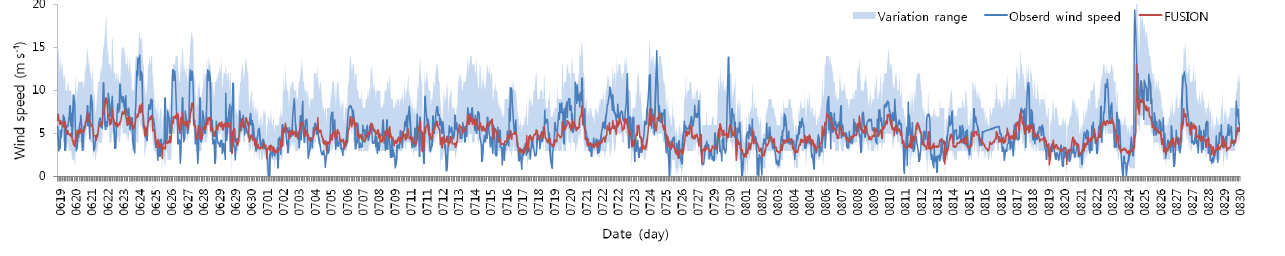
Figure 3. The contrast of 0–24h single-valued forecast, variation range of wind speed and hourly observed wind speed in the verification